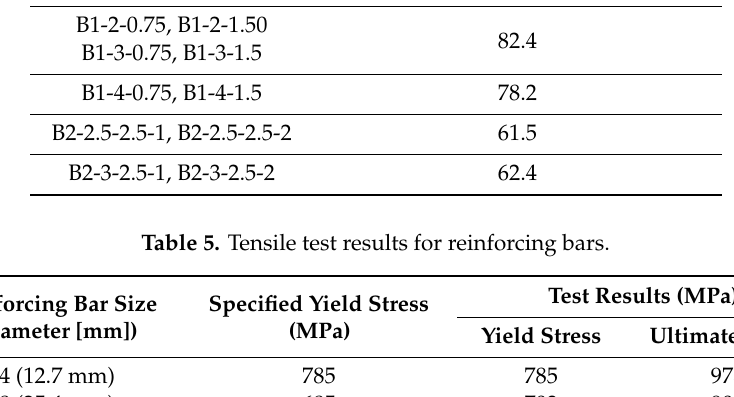
Table 4. Compression test results for concrete cylinders.